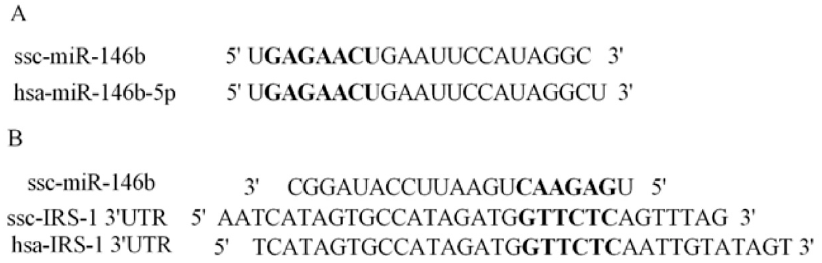
Figure 6. Conserved analysis of miR-146b and its target gene across species.( A ) The bold letter showed that porcine miR-146b shared the same sequences of seed region with human miR-146b; ( B ) The bold pointed out that 3 ′ UTR of human IRS1 mRNA is in accordance with ssc-miR-146b binding site.